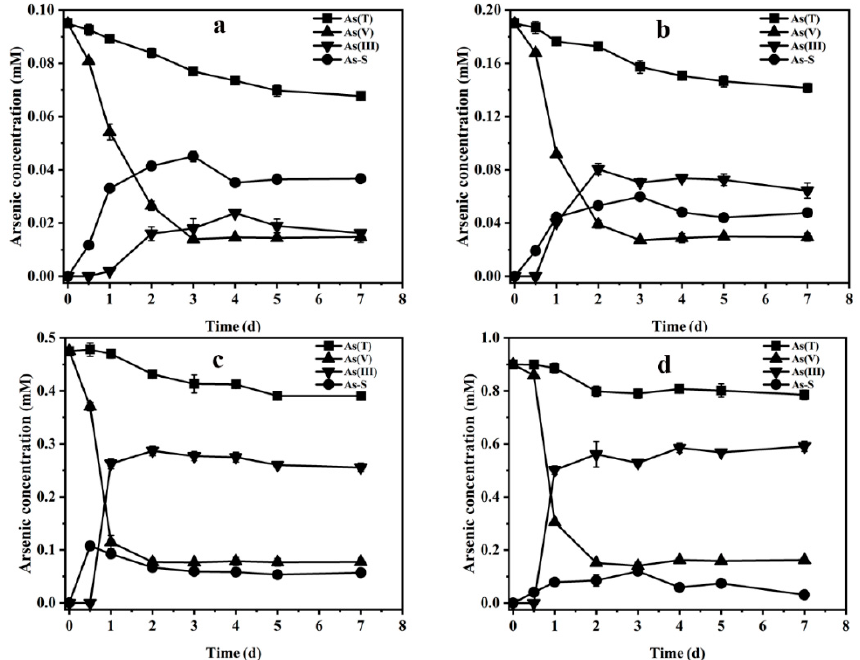
Figure 7. Changes in arsenic concentration in the medium when the ratio of sulfur to arsenic was